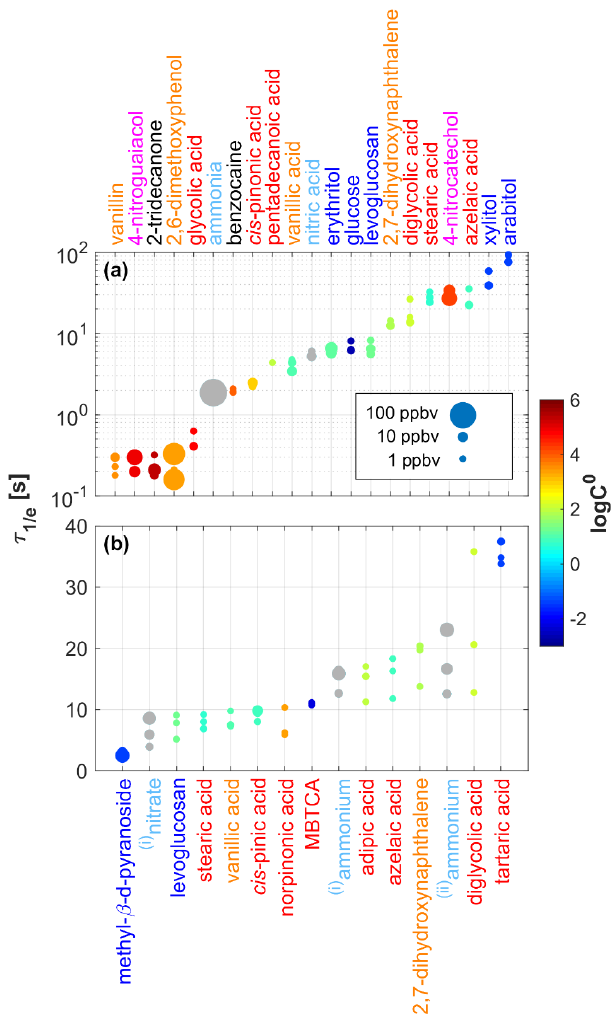
Figure 4. Signal decay times ( τ 1 /e ) measured for 21 gaseous an- alytes (a) and 15 particulate analytes (b) . Analytes were grouped and color-coded into six classes: saccharides (in dark blue), car- boxylic acids (in red), substituted phenols (in orange), nitroaromat- ics (in magenta), small polar molecules (in light blue) and others (in black). The size of the dots indicates the initial steady-state mixing ratio (0.1–100ppbv) used in the respective experiment. The color code of the data points indicates the saturation mass concentrations (log C 0 ) of the analytes as calculated using the SIMPOL.1 method (Pankow and Asher, 2008). (i) Originating from ammonium nitrate; (ii) originating from ammonium sulfate.